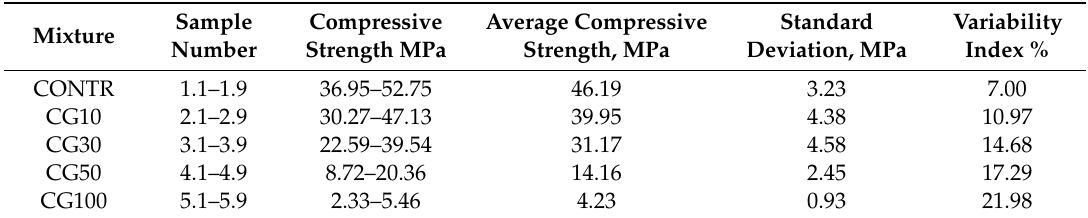
Table 12. Results of compressive strength tests for Table 11. Results of compressive strength tests for concretes. 294